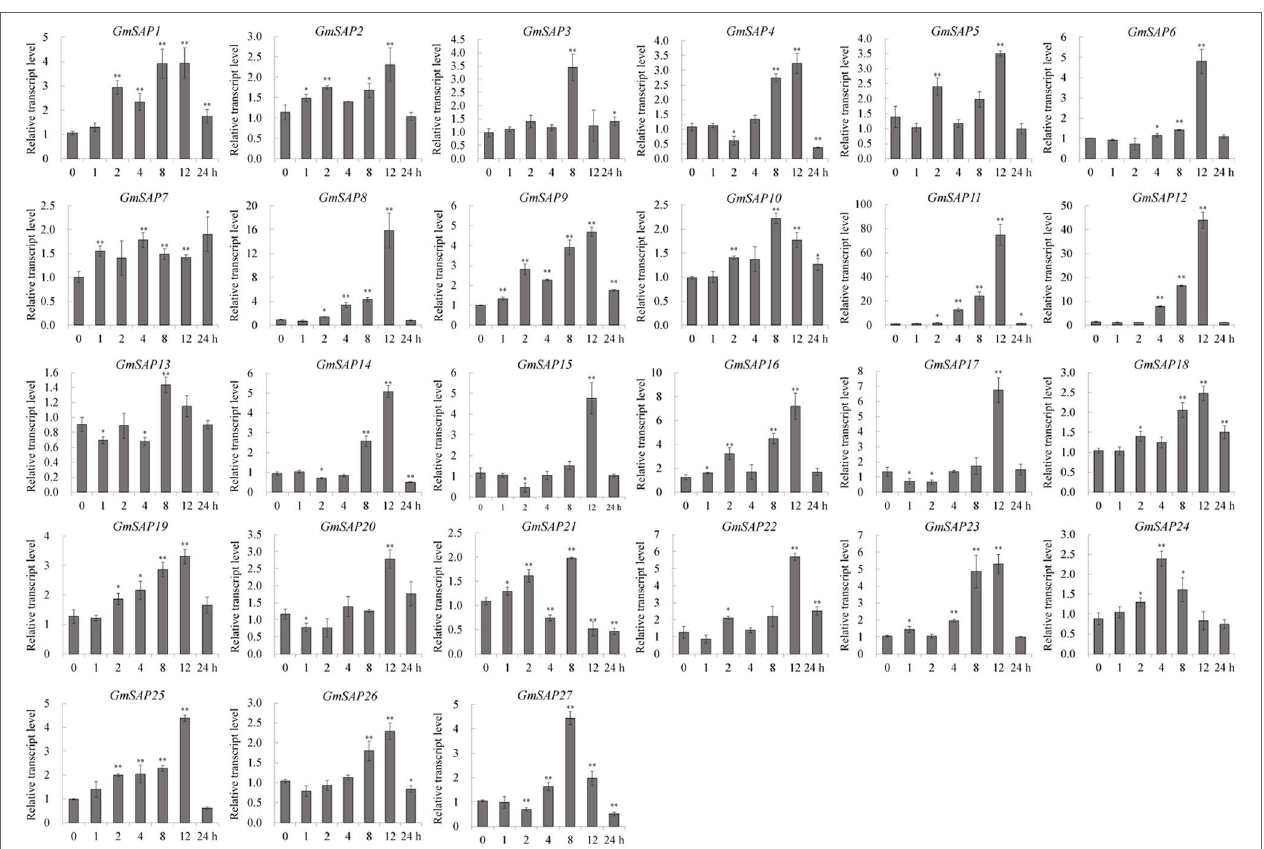
FiGURe 6 | Patterns of soybean stress associated proteins (SAPs) transcript accumulation under salt stress. The data were normalized to the soybean internal control gene GmCYP2 . Three biological replicates were performed, and the values are presented as the means ± SD. Asterisks indicate statistical significance (*, P 0.05; and **, P 0.01; Student’s t test) compared with the corresponding